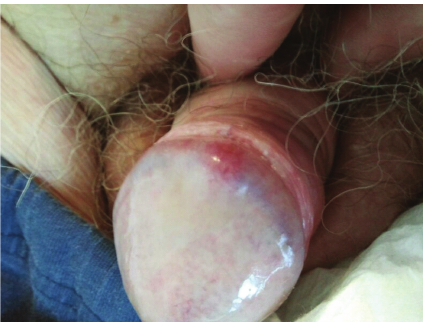
Figure 1: Focal indurated erythema on the dorsal side of the glans penis.